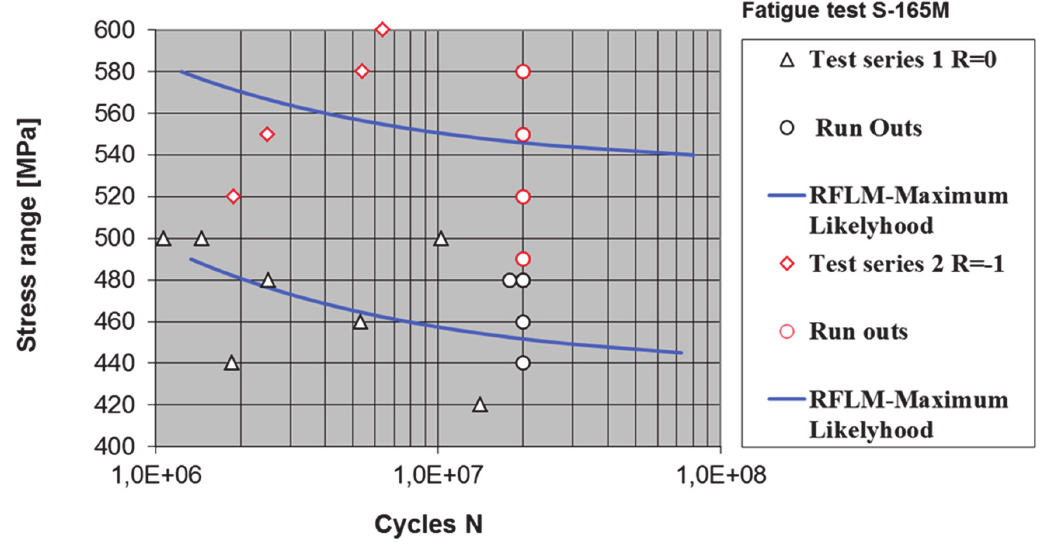
Figure 4: Illustration of mean curve change in fatigue limit from test series 1 to test series